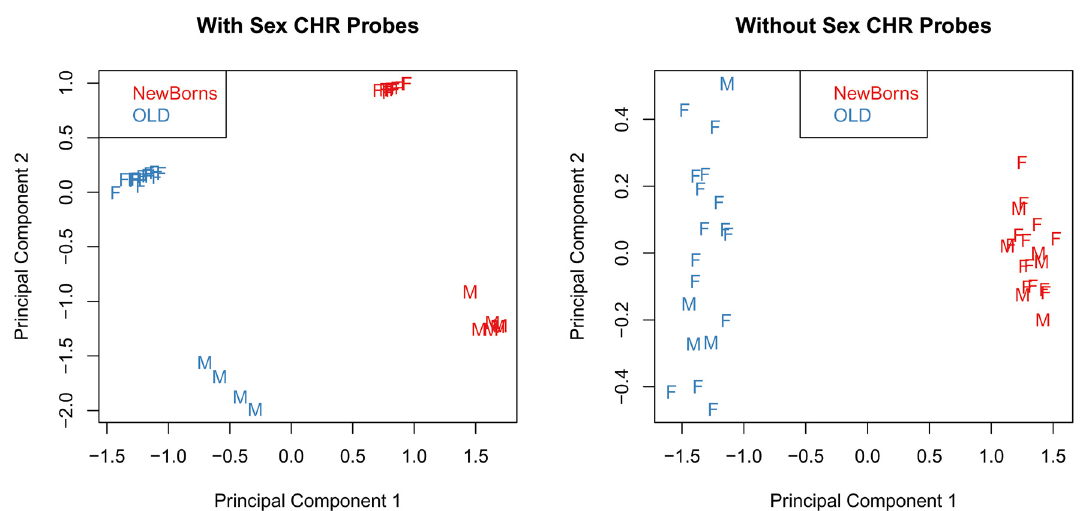
Figure 13. When samples from both males and females are included in a study, sex is usually the largest source of variation in methylation